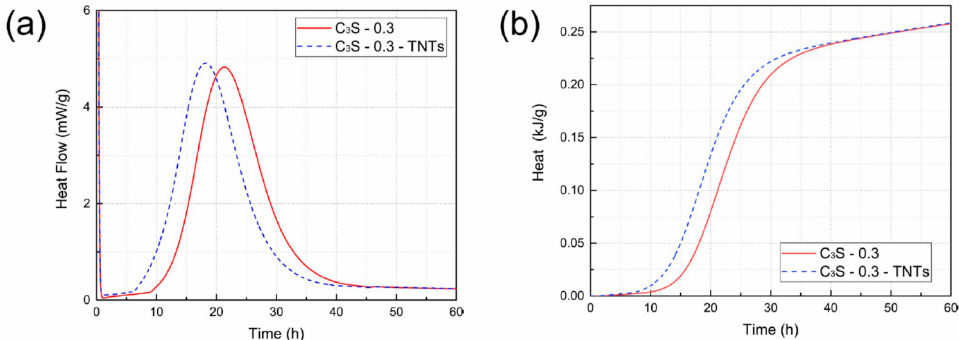
Figure 7. ( a ) Heat flow of C 3 S with and without TNTs measured by isothermal conduction calorimetry. ( b ) Heat of hydration calculated by integration of data in ( a